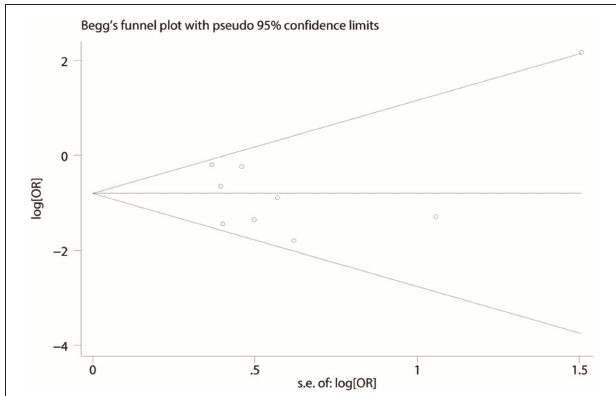
FIGURE 8 | Funnel plot depicting standard error by log relative risk.